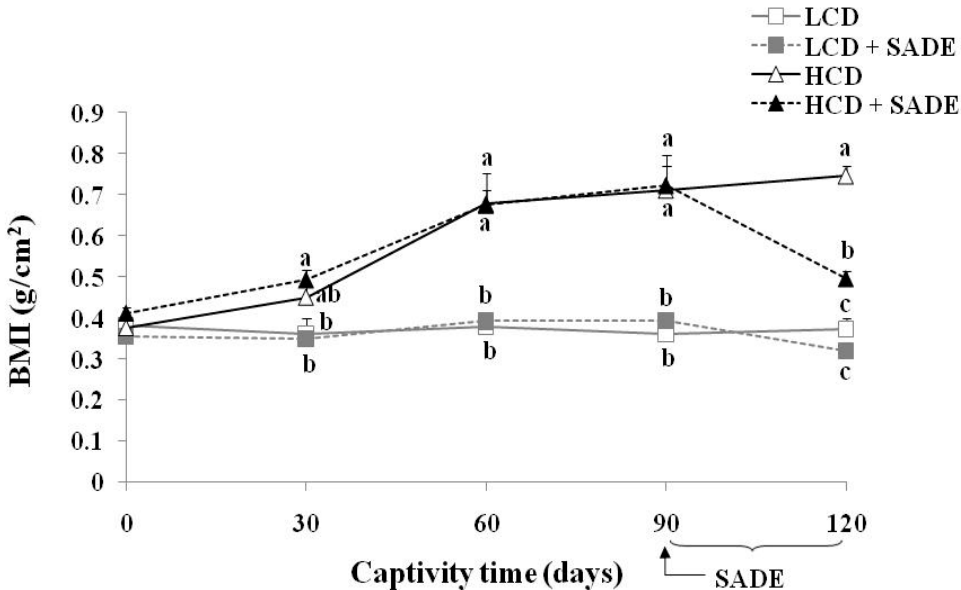
Figure 3. Body mass index, BMI (g/cm 2 ) in P. obesus in the different animal groups: LCD: animals group fed with natural low-calorie vegetable diet, LCD + SADE: LCD treated with S. arabica decocted, HCD: rats fed with high-calorie diet and HCD + SADE: rats fed with high-calorie diet treated with S. arabica decocted extract. Results are presented as means ± SD for ten rats in each group. Means not sharing the same superscript letters (a, b, c) for each captivity time are significantly different between groups (Tukey’s post hoc test, p < 0.05). “a” denotes the highest value and “c” represents the lowest value.